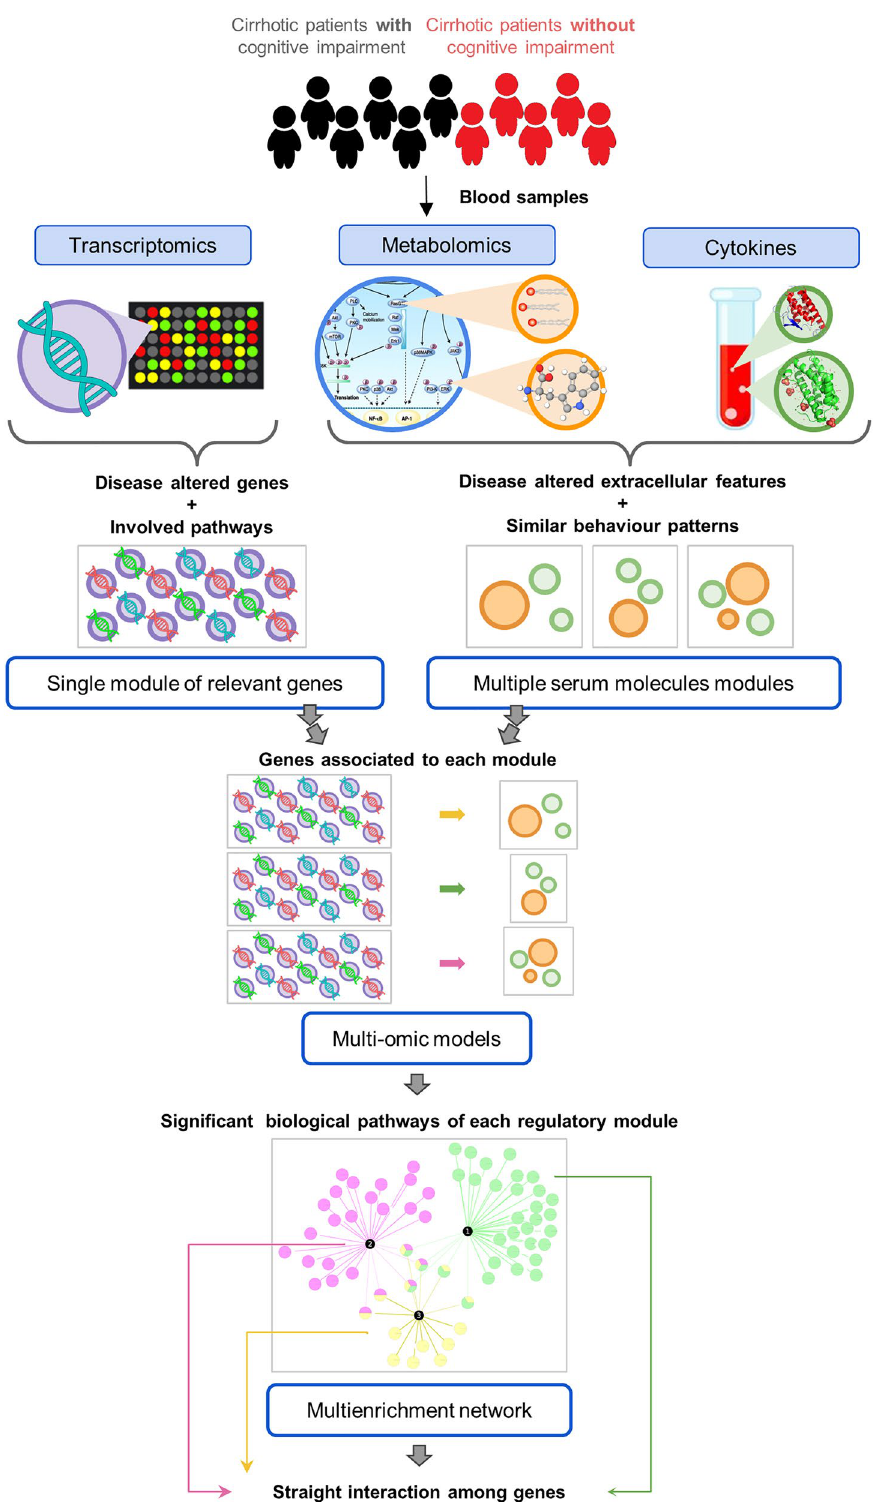
Figure 1. Summary of the analysis pipeline. Transcriptomics, metabolomics and cytokines were measured in blood samples of 11 cirrhotic patients (6 with and 5 without MHE). Step 1: genes and pathways altered in MHE. Step 2: altered metabolites and cytokines grouped by correlation. Step 3: integration of extracellular and intracellular datasets. Step 4: enrichment and network analysis of iterative